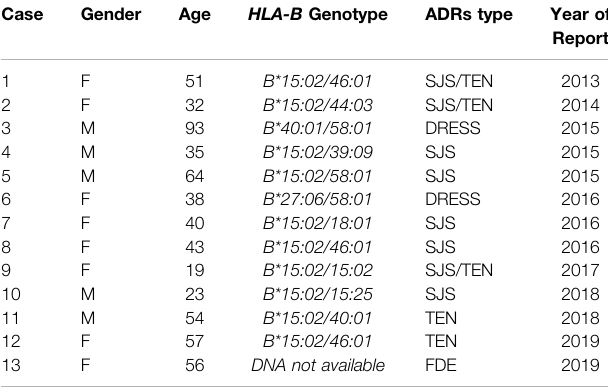
TABLE 3 | Cases of CBZ/OXC-induced SCARs and fi xed drug eruption after received CBZ without PGx